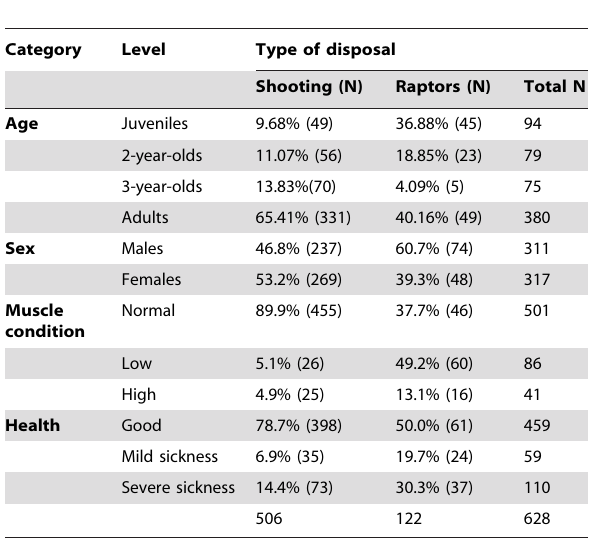
Table 3. Individual traits of gulls removed by shooting or by the use of birds of prey.